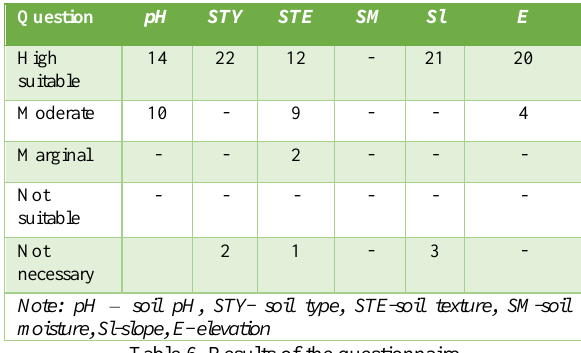
Table 6. Results of the questionnaire